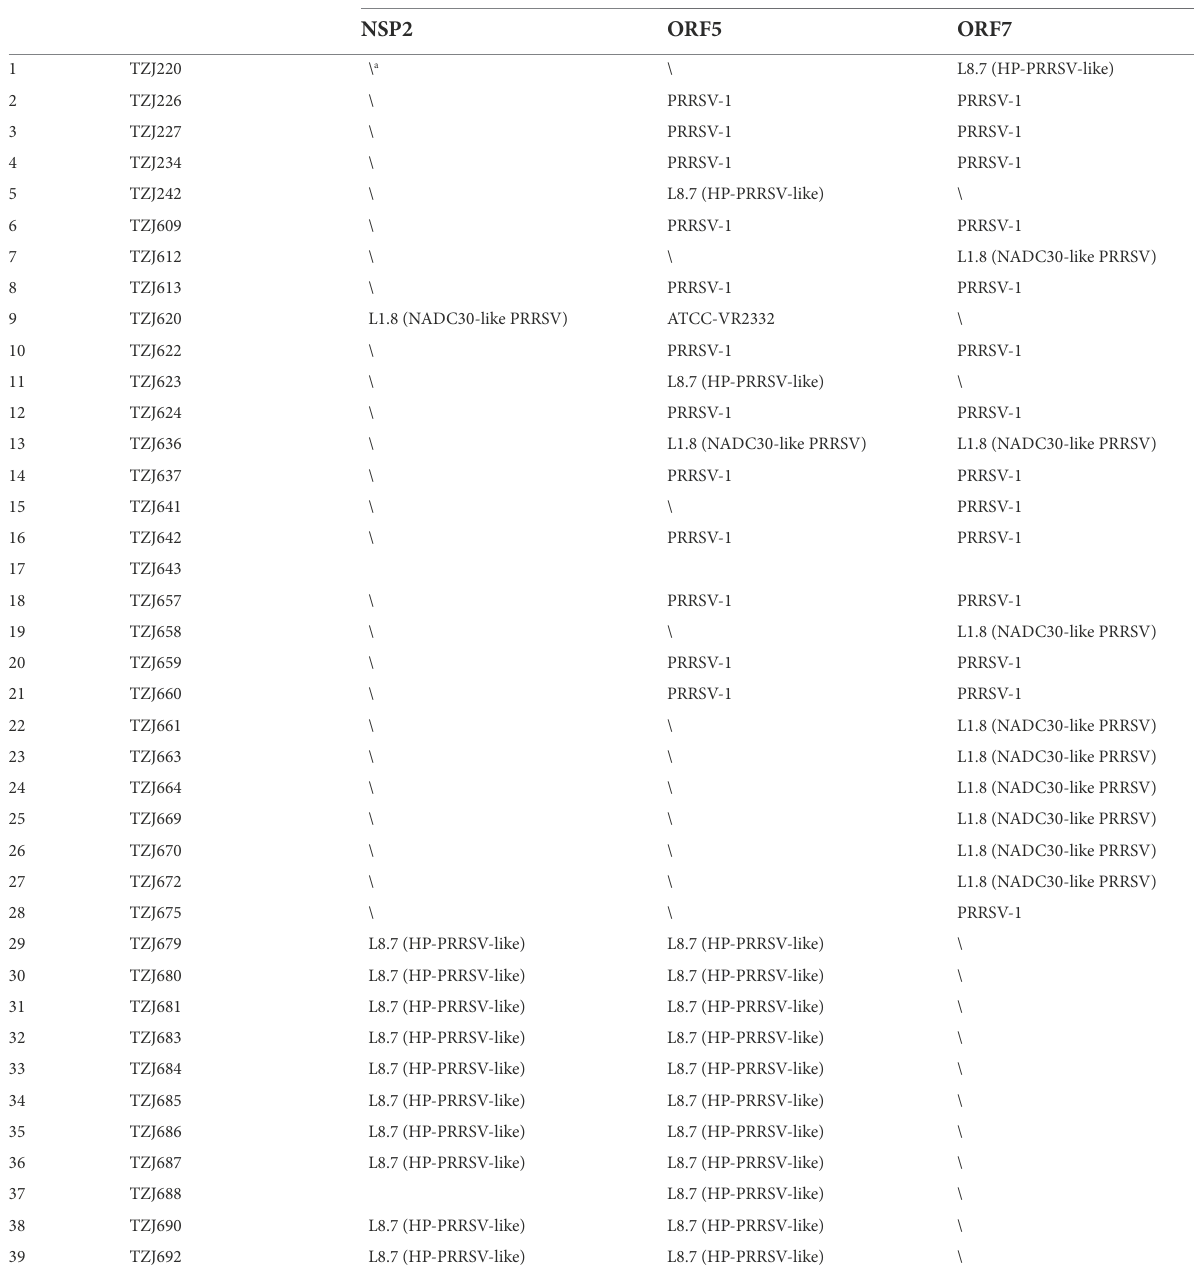
TABLE 1 PRRSV identification